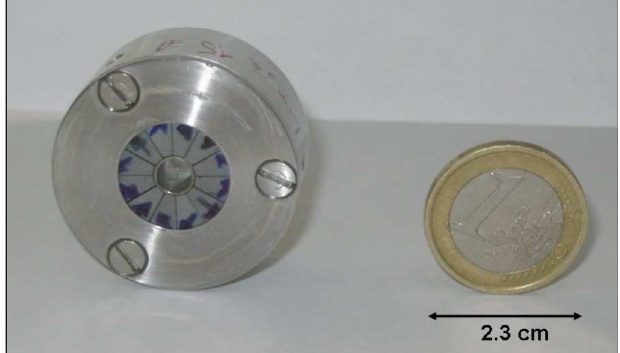
FIG. 9. (Color) Photograph of one mounted miniature quadru- pole magnet.